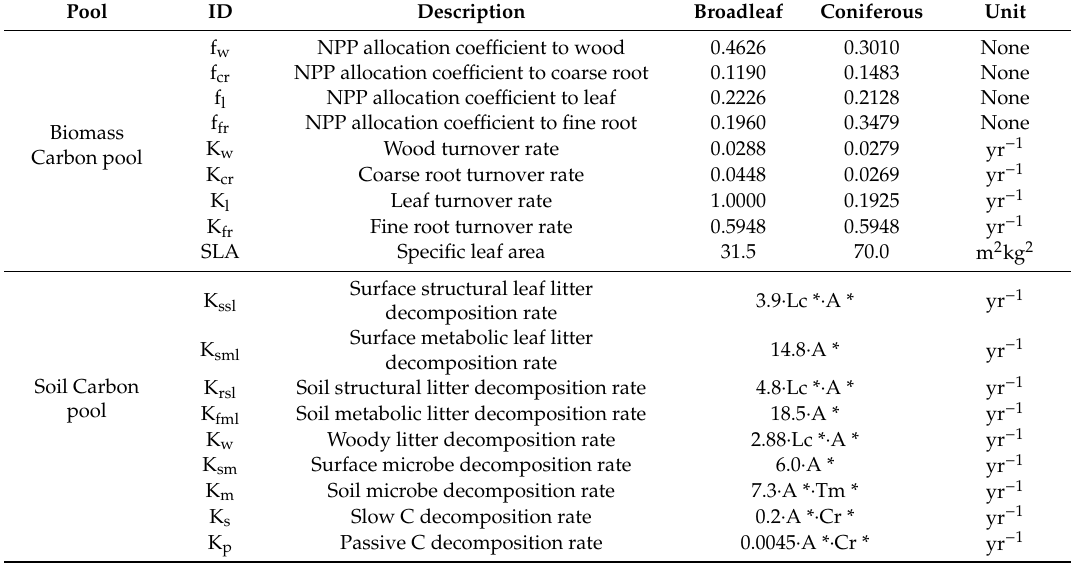
Table 1. Partition coe ffi cients, turnover rates, and decomposition rates of vegetation and soil carbon. Pool